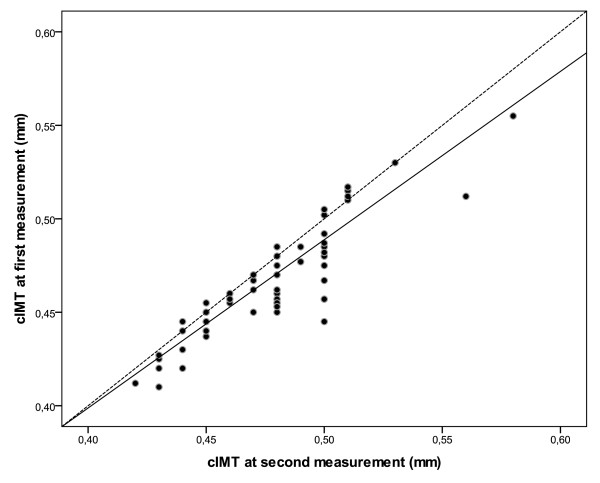
Close association of cIMT measurements at baseline and after 4 years, solid line represents the fit line at total and broken line represents the reference line from the equation y = x.